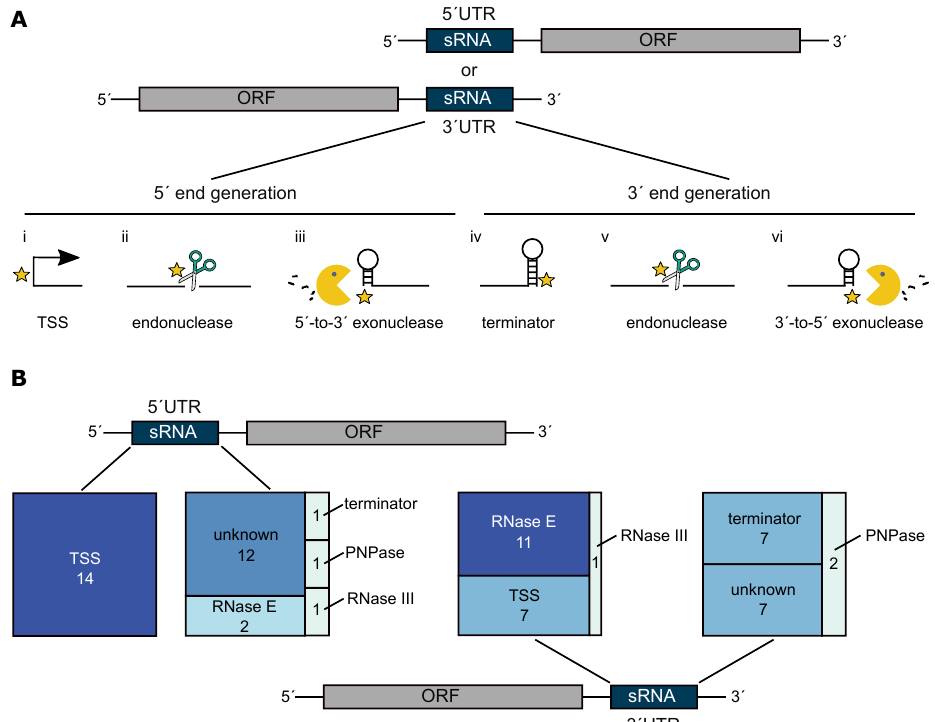
Figure 2. Predicted generation mechanisms of all UTR-derived sRNAs. ( A ) Independently of the location (5 (cid:48) or 3 (cid:48) UTR), the sRNA ends can be generated via different mechanisms. The options for the 5 (cid:48) end generation include a transcription start site (i), an endonucleolytic cleavage (ii) or a 5 (cid:48) -to-3 (cid:48) processing (iii). A terminator (iv), an endonucleolytic cleavage or an 3 (cid:48) -to-5 (cid:48) exonuclease can contribute to the RNA 3 (cid:48) end formation. ( B ) The generation mechanism of all UTR-derived sRNA ends in R. sphaeroides was determined using predictions of transcription start sites, Rho-independent terminators and RNase III/RNase E/PNPase-dependent 5 (cid:48) /3 (cid:48) ends. All 5 (cid:48) ends of the 5 (cid:48) UTR-derived sRNAs are generated by transcription start sites, the 3 (cid:48) ends are mostly formed by an unknown mechanism. RNase E (5 (cid:48) ends) and Rho-independent terminators (3 (cid:48) ends) account for the formation and processing of 3 (cid:48) UTR-derived sRNAs. Nevertheless, unknown factors are likely to contribute to the 3 (cid:48) end